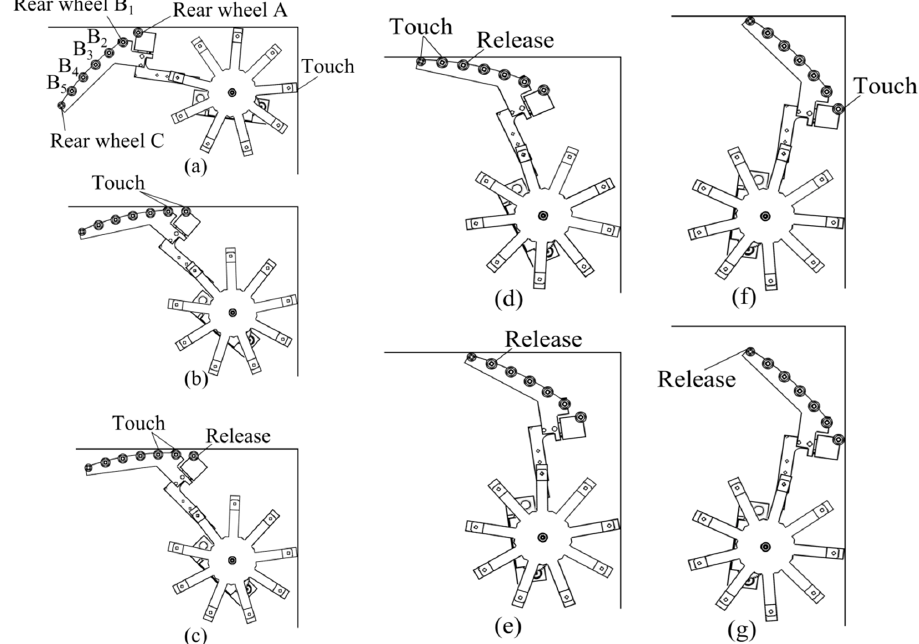
Figure 8. Robot running along the right-angled route. ( a ) Front wheel touches the vertical wall after the robot moving horizontally; ( b ) rear wheel B 1 touches the ceiling as well as the rear wheel A; ( c ) after rear wheel A released, rear wheel B 2 touches the ceiling promptly; ( d ) after rear wheel B 4 released, rear wheel C touches the ceiling promptly; ( e ) rear wheel B 5 is released from the ceiling; ( f ) while the rear wheel C is in contact with the ceiling, the rear wheel A contacts the vertical wall; ( g ) rear wheel C is released from the ceiling and the robot descends.